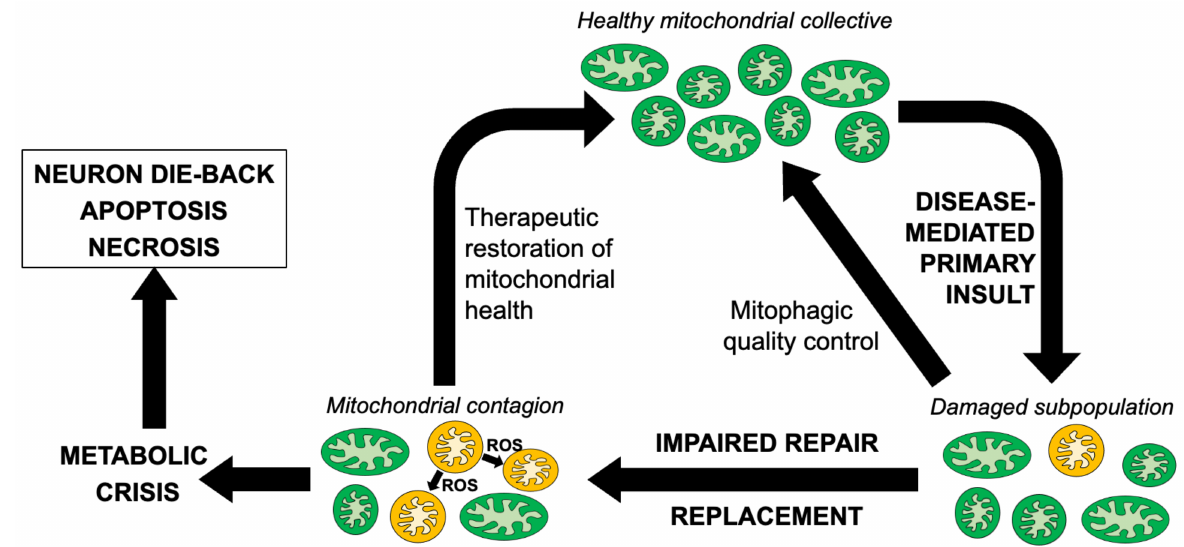
Figure 1. Schematic depiction of reparative mechansisms and the putative cycle of mitochondrial degen- eration contributing to neuromuscular dysfunction in ALS and similar neurodegenerative